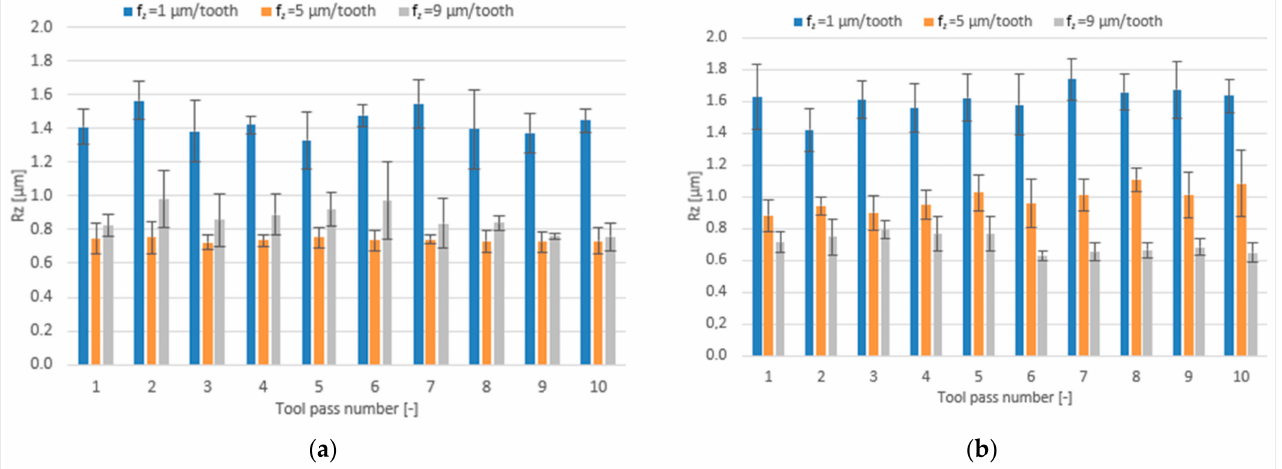
Figure 13. Feed per tooth f z versus surface roughness parameter Rz in the milling process performed using a tool coated with: ( a ) TiB 2 and ( b ) TiAlN; (v c = 800 m/min; a p = 80 µ